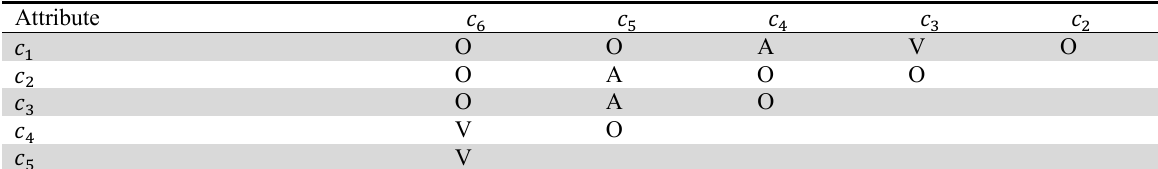
SSIM for supplier evaluation